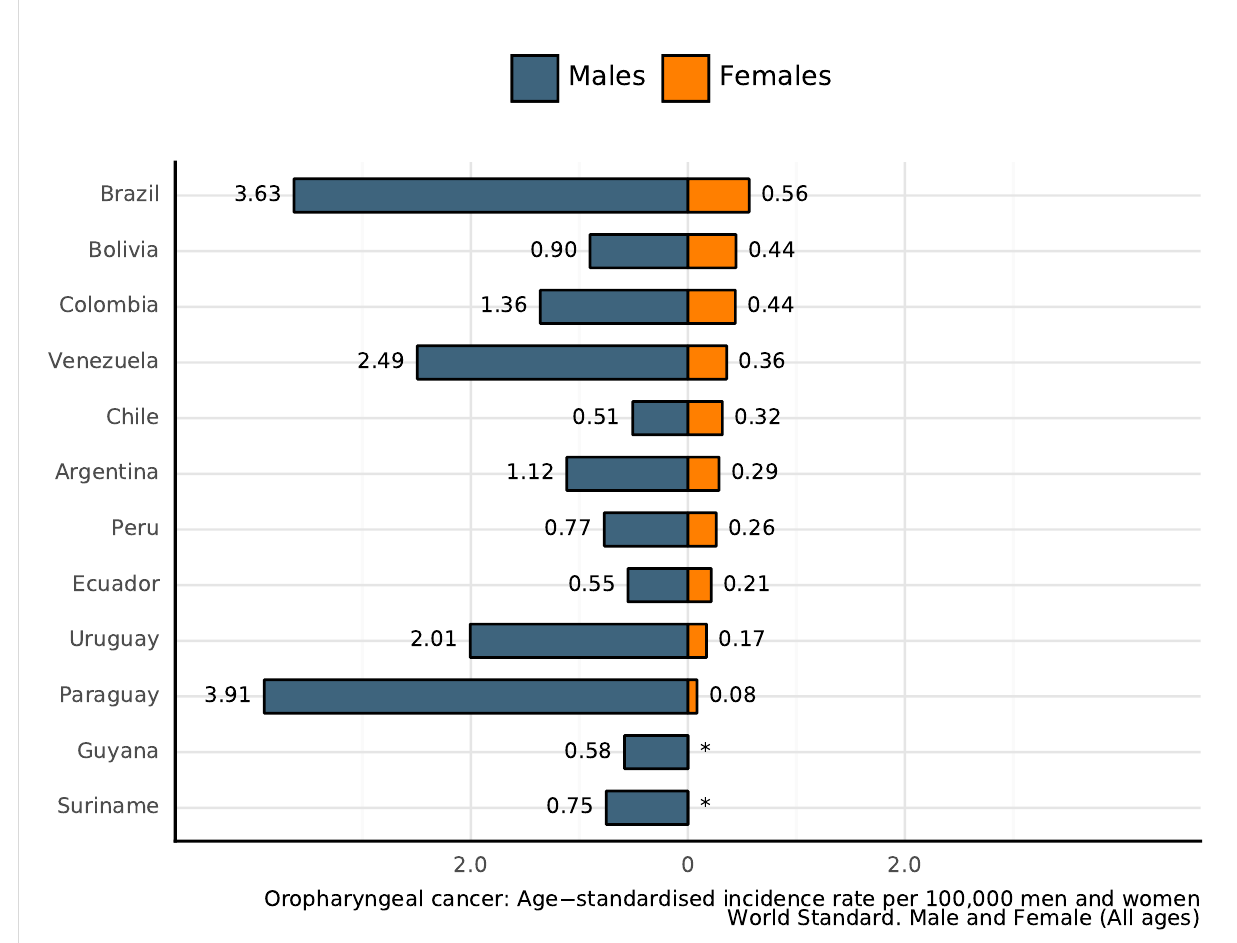
Oropharyngeal cancer: Age standardised incidence rate per 100,000 men and women World Standard. Male and Female (All